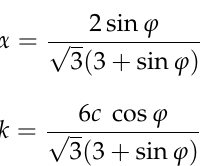
Figure 6. A front view of the impacted flexible barrier after maintenance.